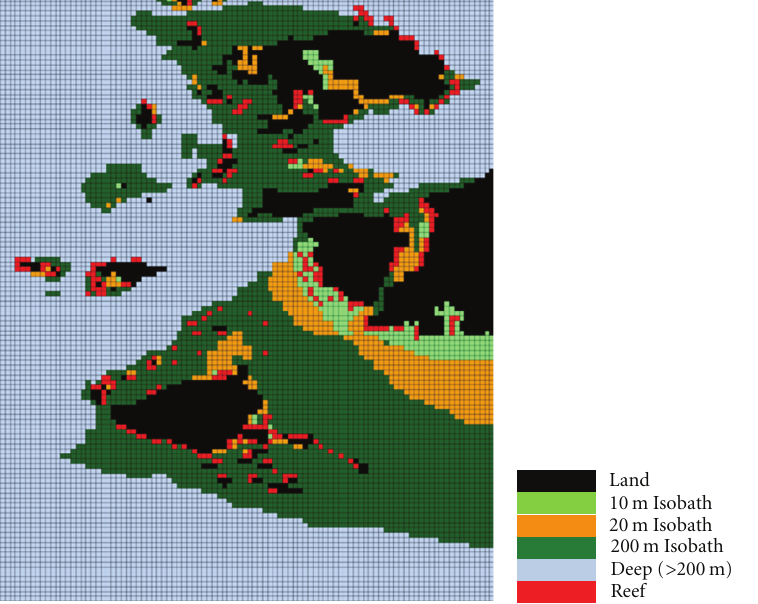
Figure 2: Raja Ampat Ecospace habitat map. Each cell in the map is approximately 2.56 ×